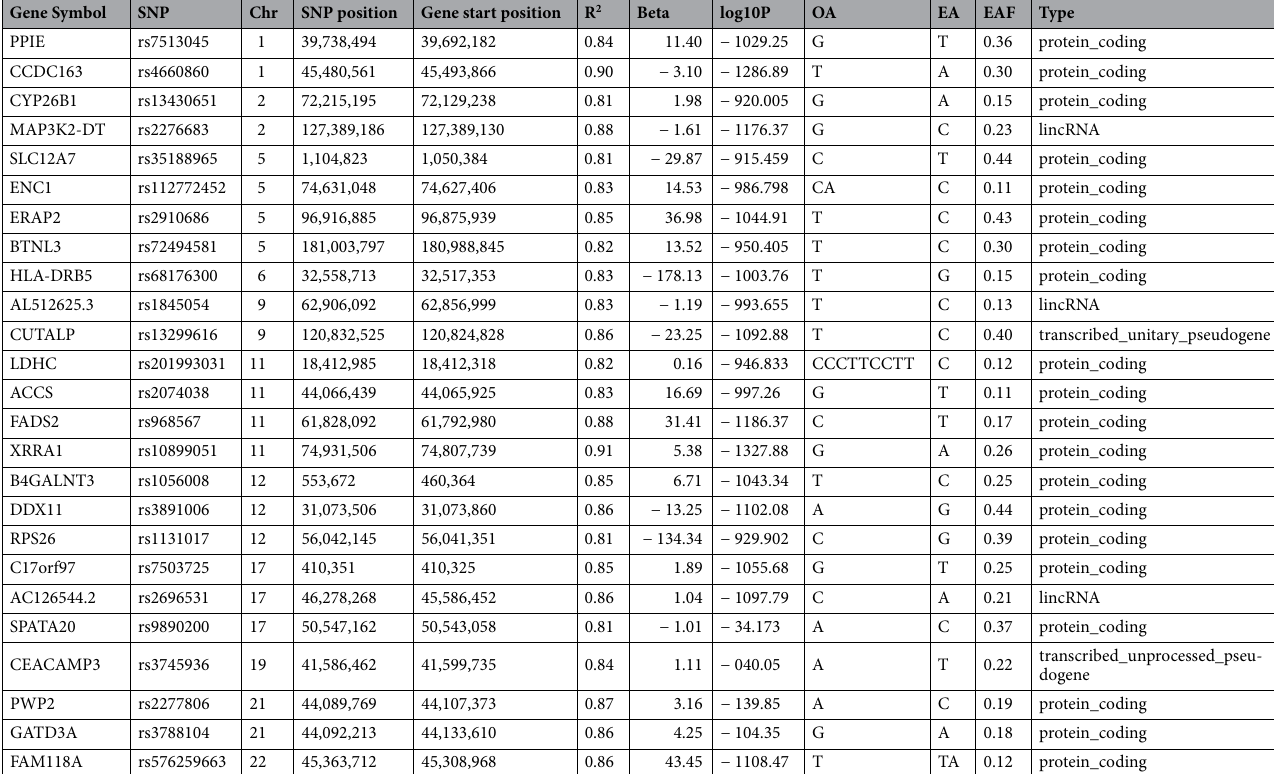
Table 1. Top 25 cis-eQTLs ( p < 5e−8). EA effect allele, OA the other allele, EAF effect allele frequency; R 2 variance explained by the lead eQTL (SNP).